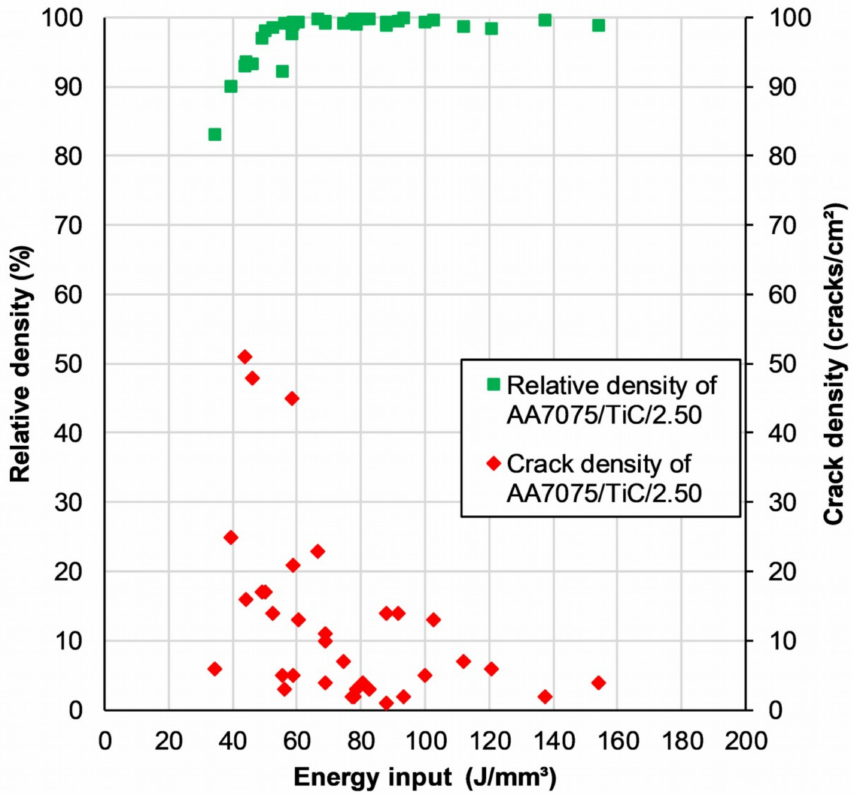
Figure 5. Correlation of the relative sample density and the crack density using powder variant AA7075/TiC/2.5 with the induced volumetric energy input from